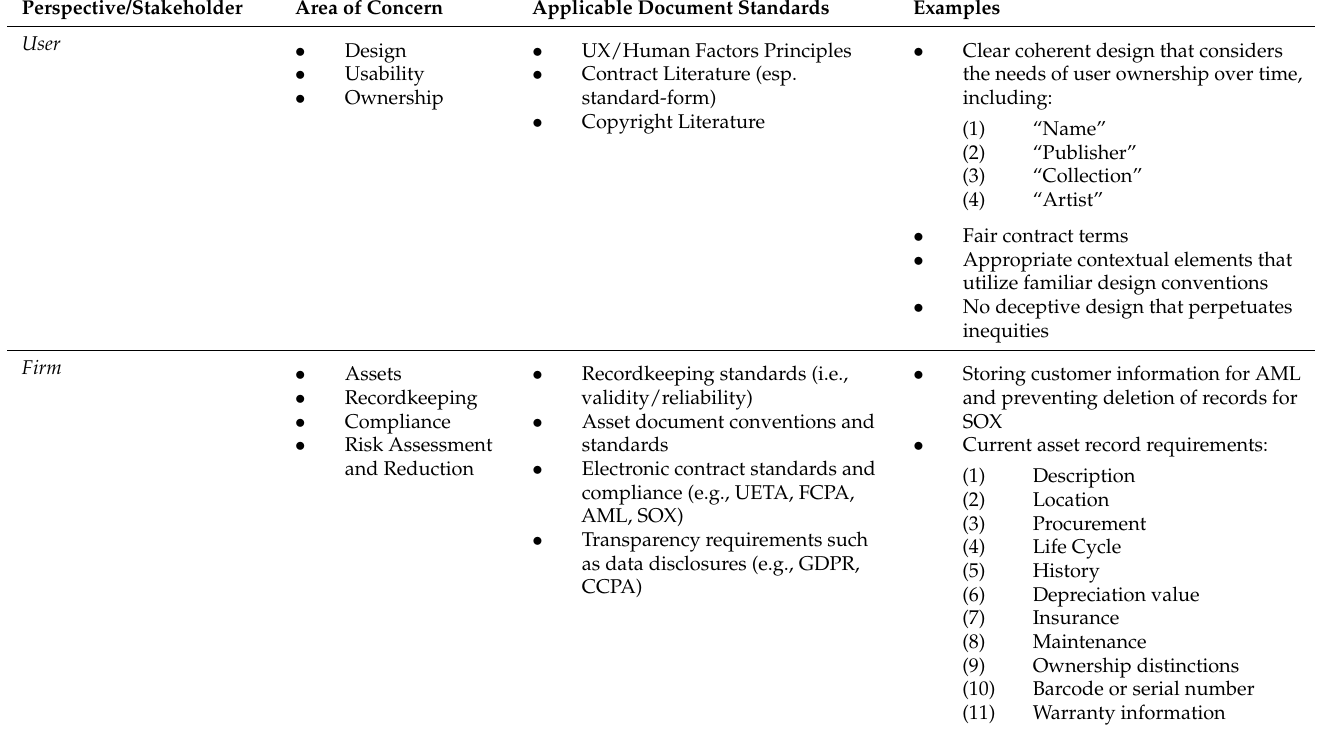
Table 1. Description of